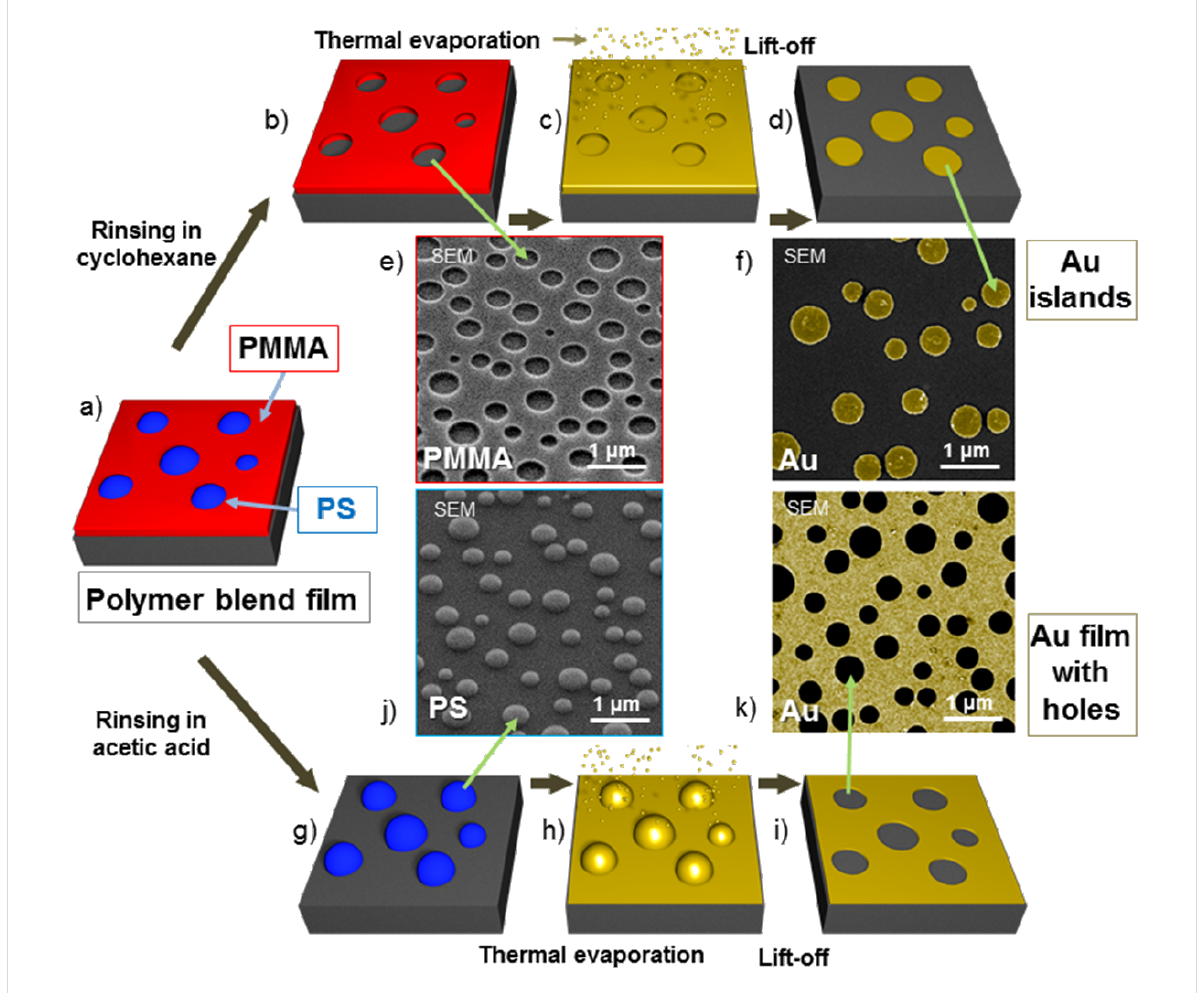
Figure 1: Schematic drawing and experimental results of the metal PBL process for the fabrication of metal nano-patterns. a) A blend film (PS/PMMA 3:7 mass ratio) is formed through spin-coating. PS droplets are formed in a PMMA matrix, and both phases have contact to the substrate as well as to the air. b) PS droplets are selectively dissolved by cyclohexane. c) Deposition of metal via thermal evaporation. d) After lift-off via snow-jet treatment, a negative metal copy of the PMMA mask is formed. e) SEM image of a perforated PMMA film (taken at a tilting angle of 45°). f) SEM image of gold islands. g) The PMMA matrix is selectively dissolved by acetic acid. h) Deposition of metal via thermal evaporation. i) After lift-off via snow jet, a nega- tive metal copy of the PS mask is formed. j) SEM image of PS droplets (taken at a tilting angle of 45°). k) SEM image of a perforated gold